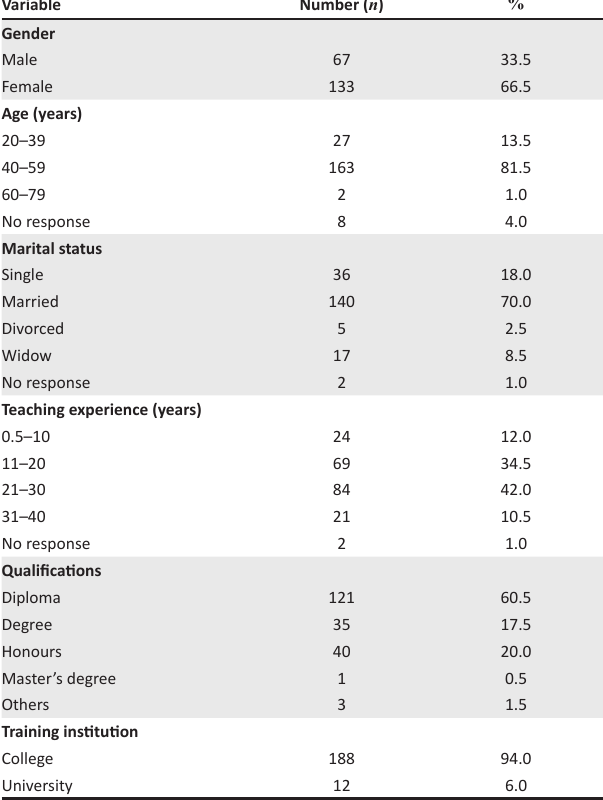
TABLE 1: The socio-demographic characteristics of the educators.